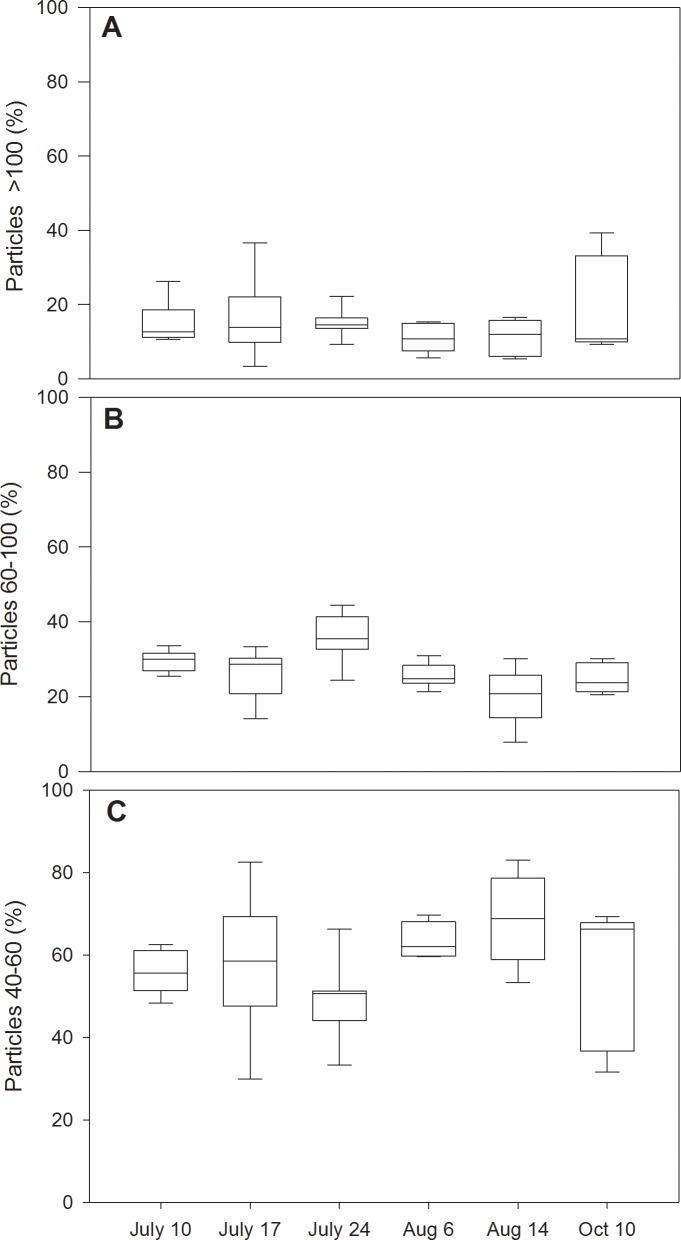
Box plots of Ag temporal variation among sampling dates.Ag size classes are presented as: (A) >100nm, (B) 40–100 nm, and (C) 40–60 nm sizes. Box plots are defined by 25th and 75th percentiles with a median line. Error bars represent 10th to 90th percentiles.